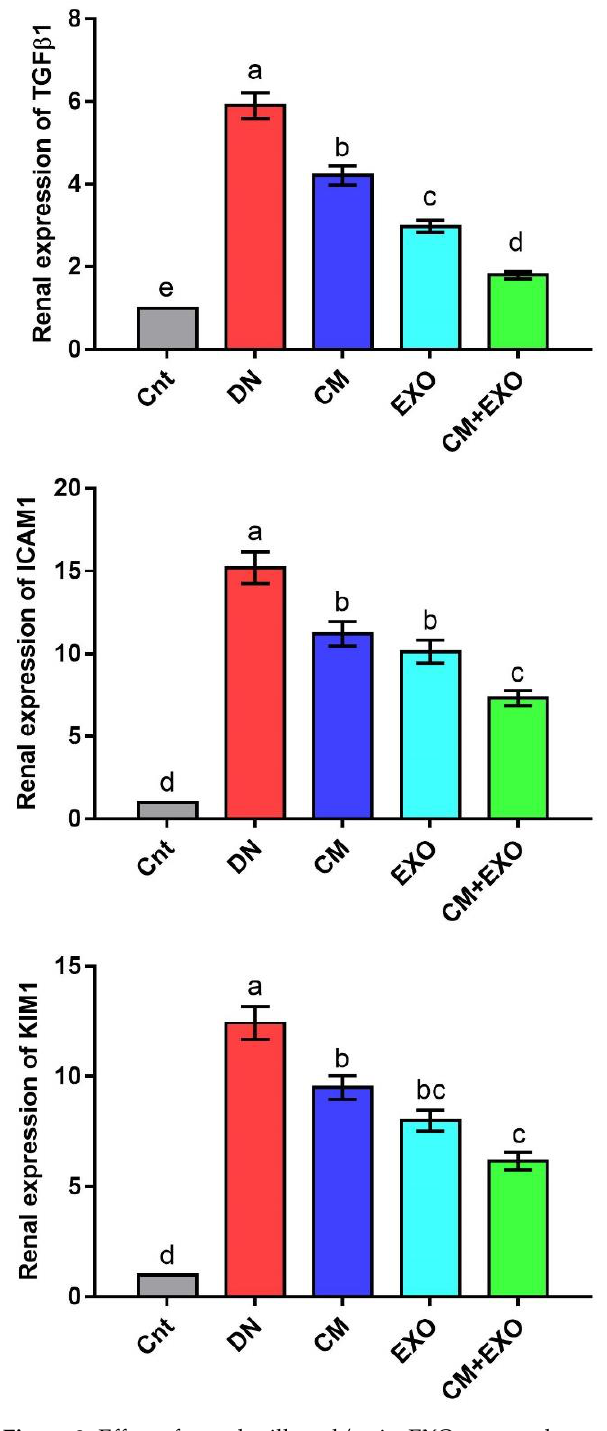
Figure 3. Effect of camel milk and/or its EXOs on renal expression of fibrosis-related genes ( TGFβ1 and ICAM1 ) and the kidney injury-related gene ( KIM1 ) as detected by real-time PCR. Values were expressed as fold change mean ± SEM (n = 6/group). Columns carrying different letters (a (the highest value) – e (the lowest value)) are significantly different at p < 0.05. All groups were compared to each other. Each data point represents an average of three independent experiments with three replicates for each. Cnt, control group; DN, diabetic nephropathy group; CM, camel milk-treated group; EXO, camel milk exosomes-treated group; CM + EXO, co-treated group with camel milk and its exosomes.